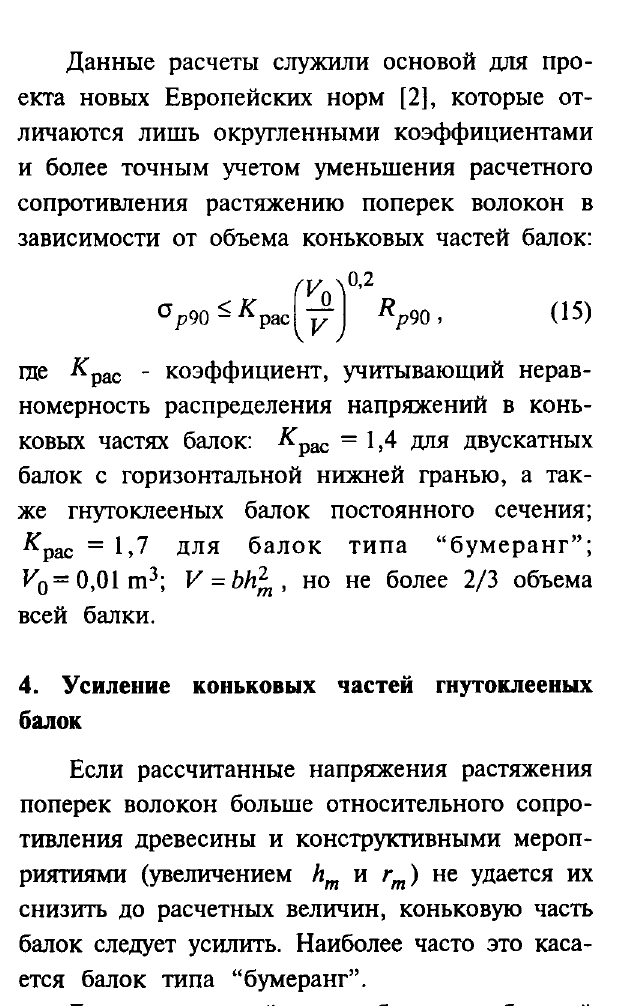
eTC.SI 6aJIOK THna "6YMepaHr".